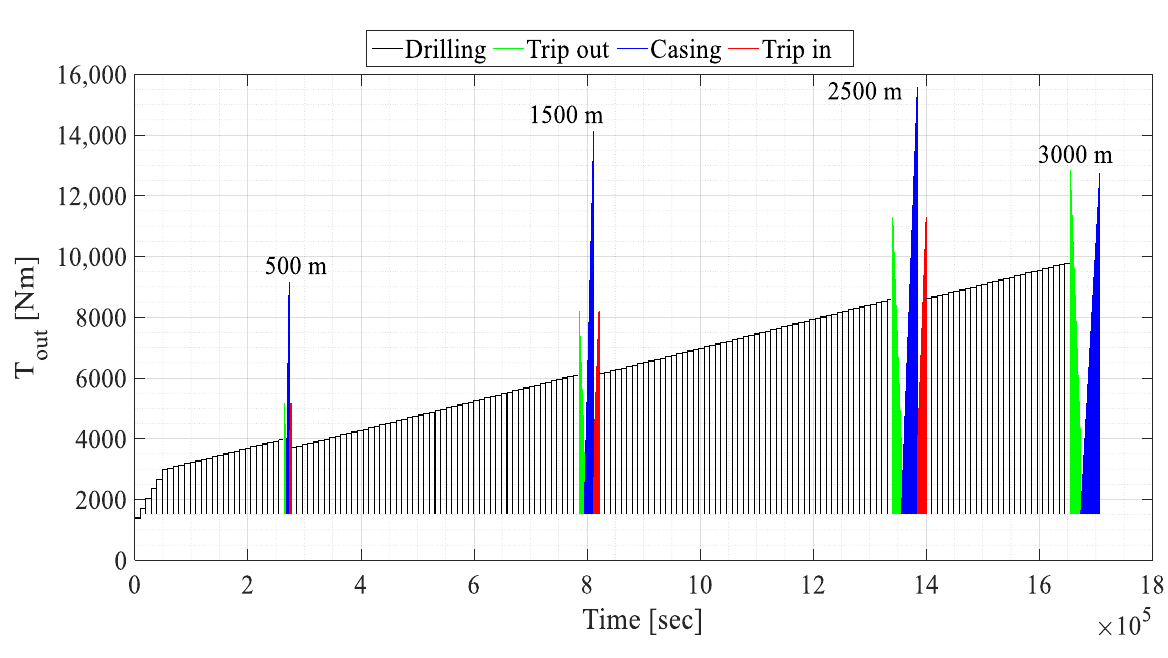
Figure 2. PSU output shaft speed.